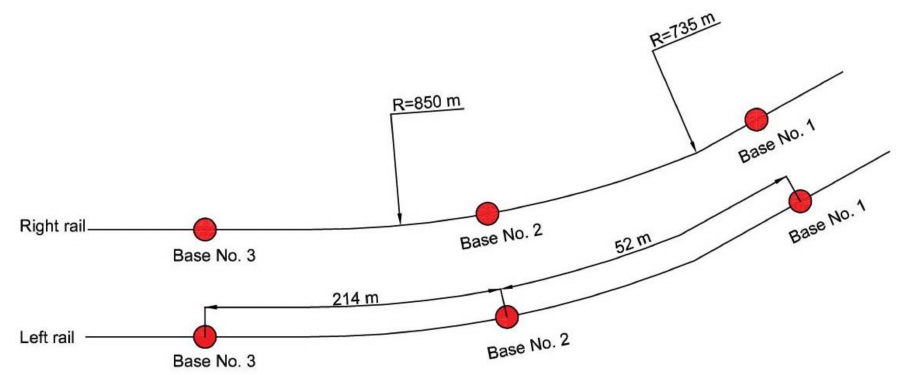
Figure 6. Distribution of measurement bases in the test section (source: own work).